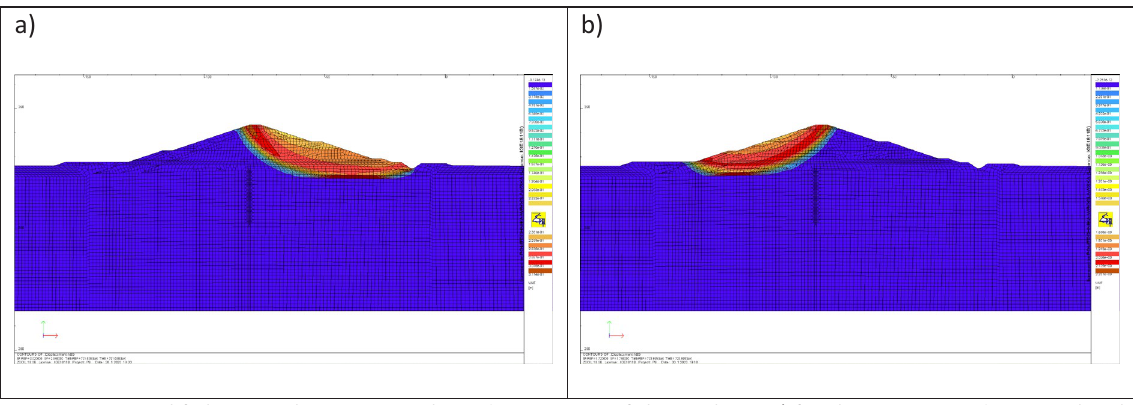
Fig. 14. Evolution of the factor of safety in time during flood wave passage for different depths of the anti -